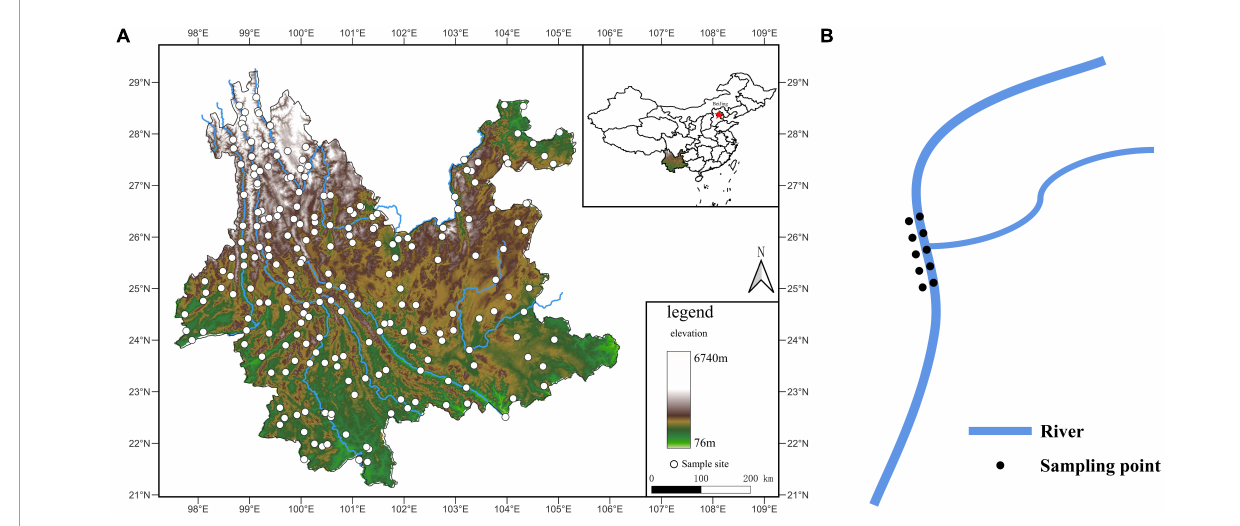
FIGURE1 (A) Sample sites map. The white dots are sampling sites. The color change of the map represents the elevation change. The blue line is the rivers. (B) Sampling diagram. The blue line is the rivers.